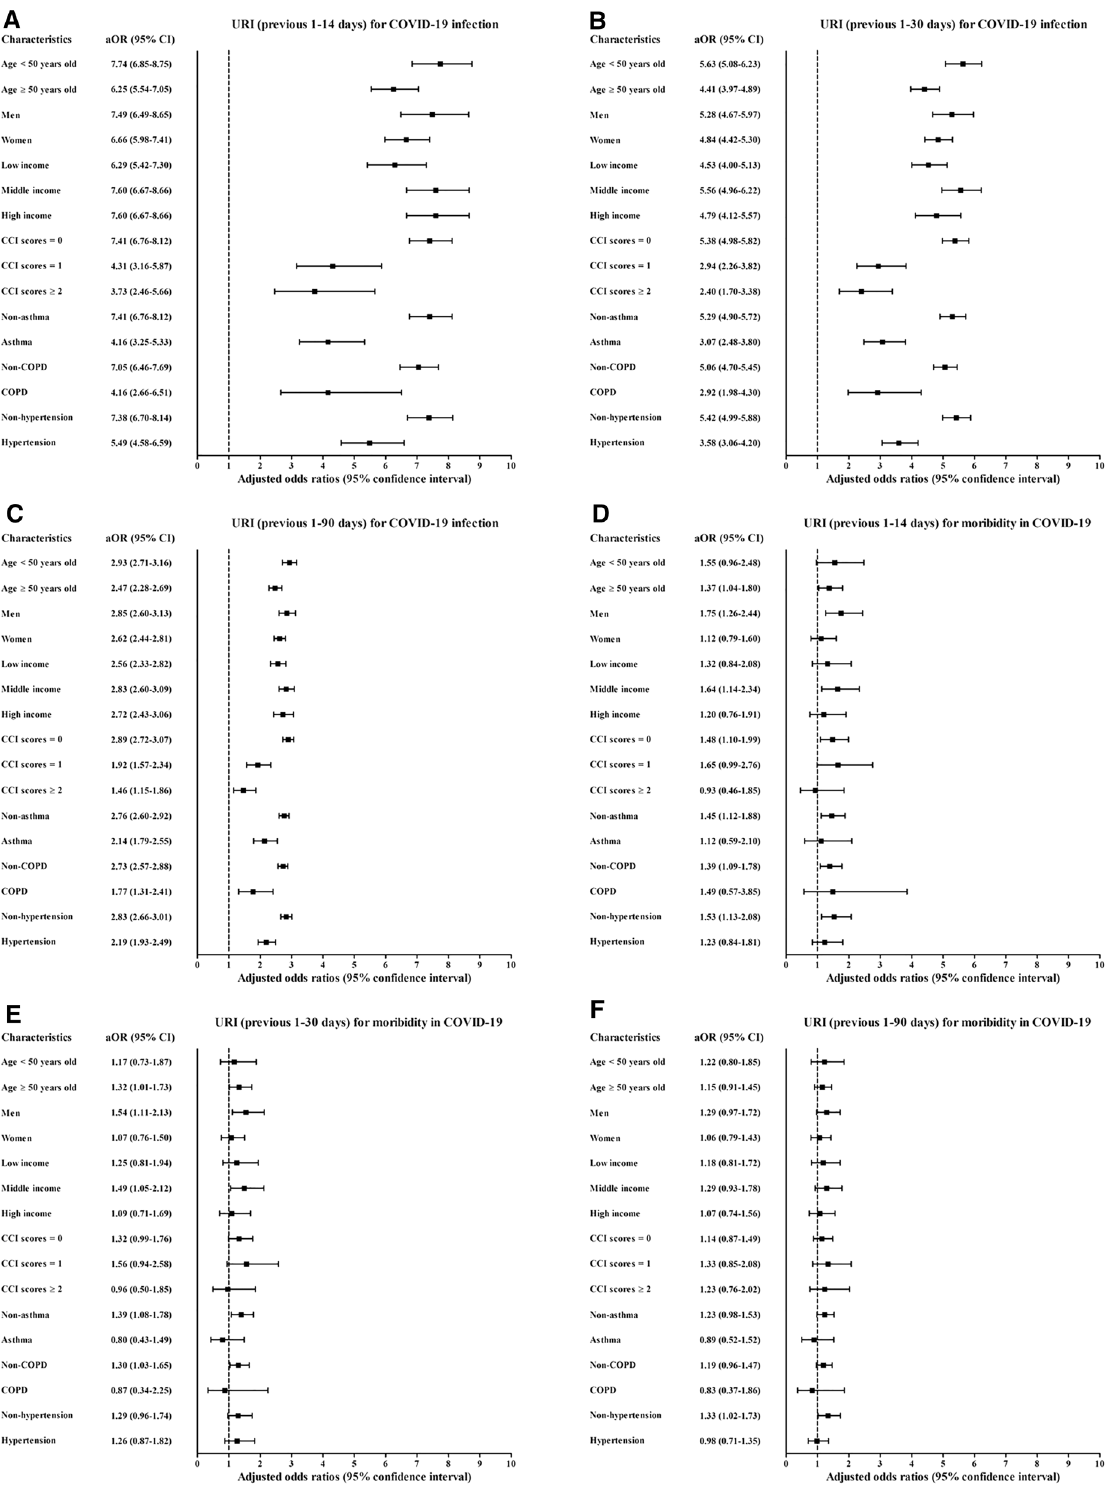
Figure 3. Subgroup analyses of the participants for COVID-19 susceptibility/morbidity/mortality by previous histories of URI regarding ( A ) susceptibility for 1–14 days, ( B ) 1–30 days ( C ), and 1–90 days; ( D ) morbidity